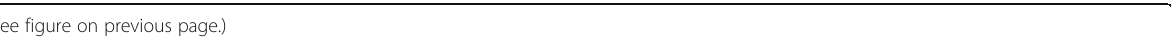
Ethyl acetate fraction of E. Ethyl acetate fraction of K. dactylon officinalis pinnata Mg/ Ca/ Ca/ PO 4 / Mg/ Ca/ Ca/ Ca/ Ca/ PO 4 / Cr Cr Ox Cr Cr Cr Ox Cr Ox Cr